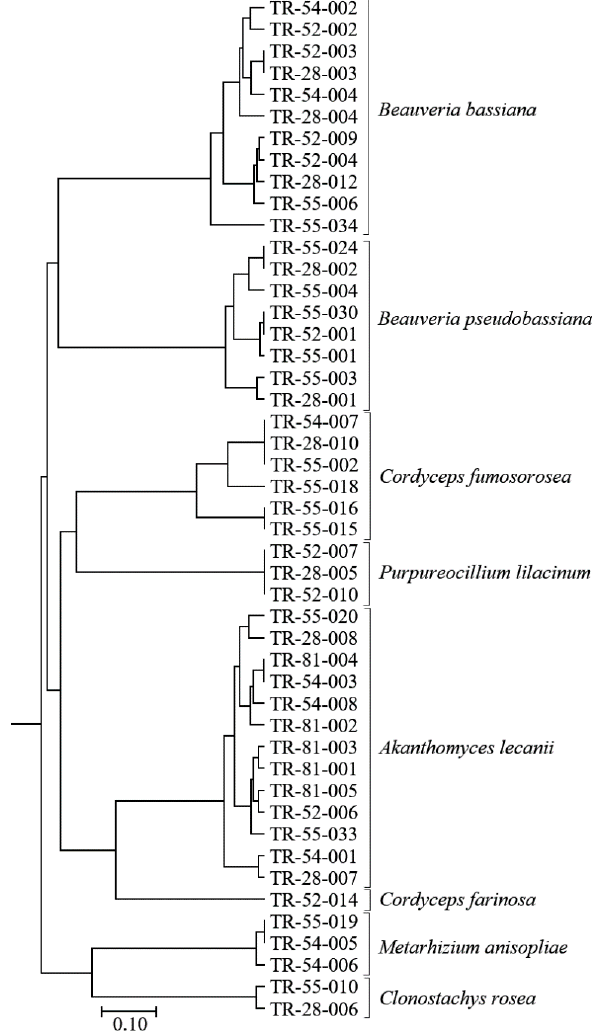
Figure 3. UPGMA cluster analysis based on Jaccard similarity coefficients, showing the genetic relationships among eight EPF species based on an iPBS profiling analysis.